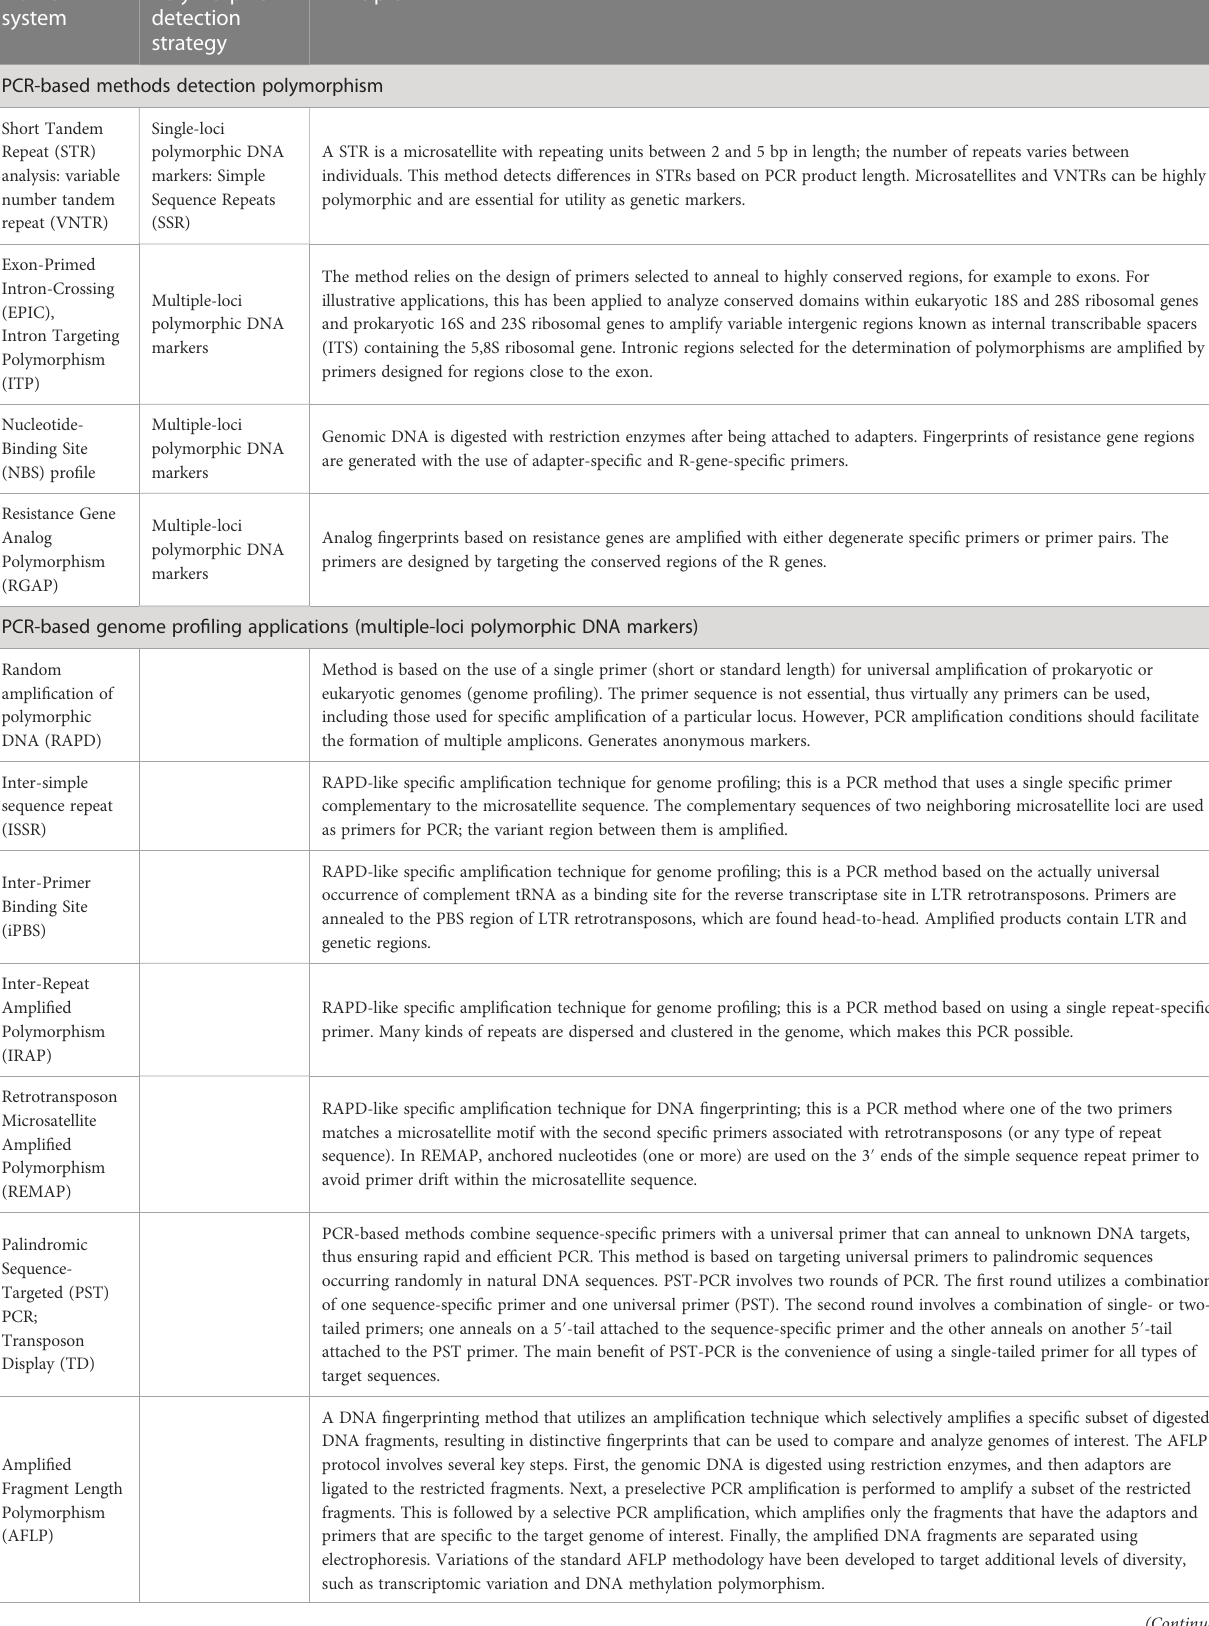
TABLE 1 Main strategies for detection of molecular genetic polymorphisms. Marker